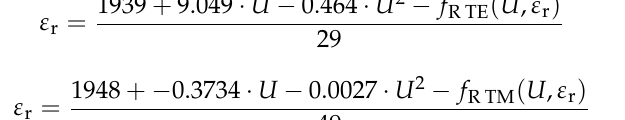
Figure 12. Examples for electric field norm with shift of tunable bar at position U = 16 µ m and Q = 0 µ m: ( a ) TM mode, ( b ) TE